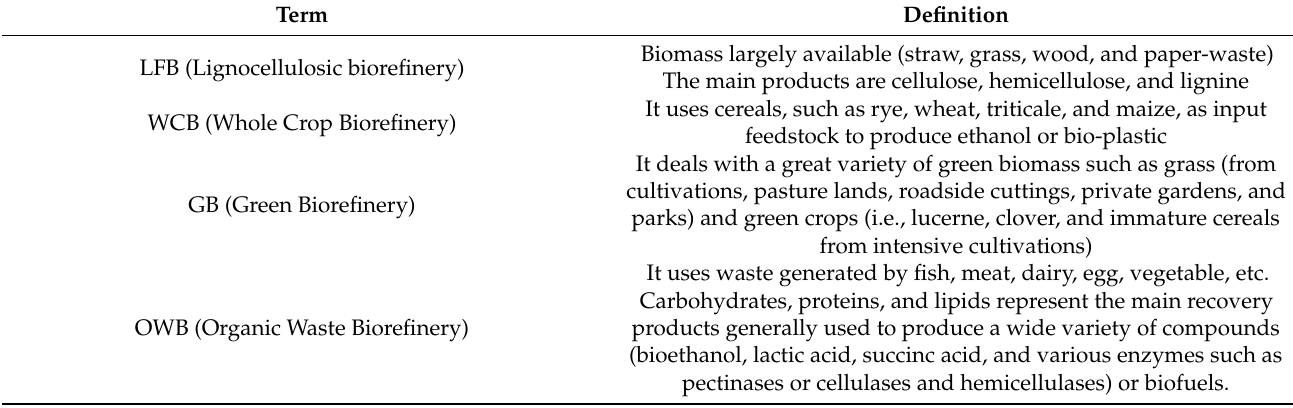
Table 2. Classification of biorefinery according to Kamm et al. [17]; the details have been adapted from various sources.